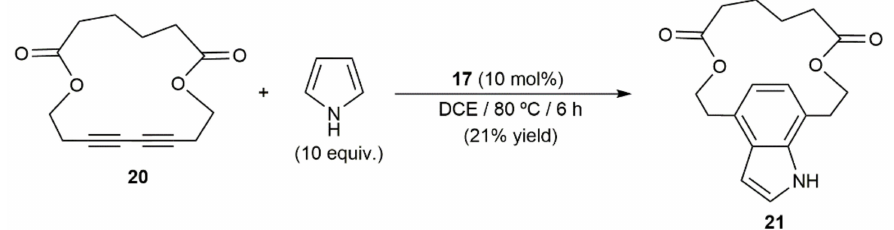
Figure 2. Structures of dictyodendrins B, C, E, and F.